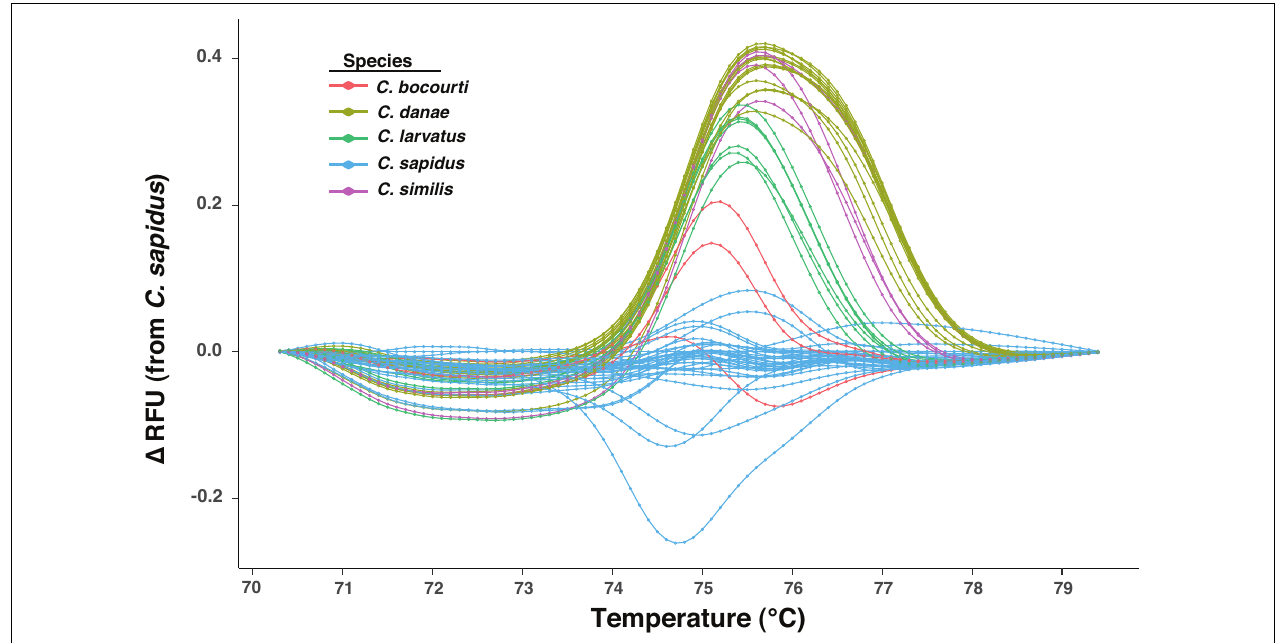
FIGURE 3 | Plot of HRM difference curves for samples from five Callinectes spp. Curves represent the change (delta, (cid:49) ) in relative fluorescence units (RFUs) across temperatures relative to a reference sample ( C. sapidus from Maryland), which plots at zero across all temperatures (no difference from itself). Curves for each sample are colored by Callinectes spp. group, which is based on NCBI BLAST results for ∼ 500 bp 12S rRNA Sanger sequence